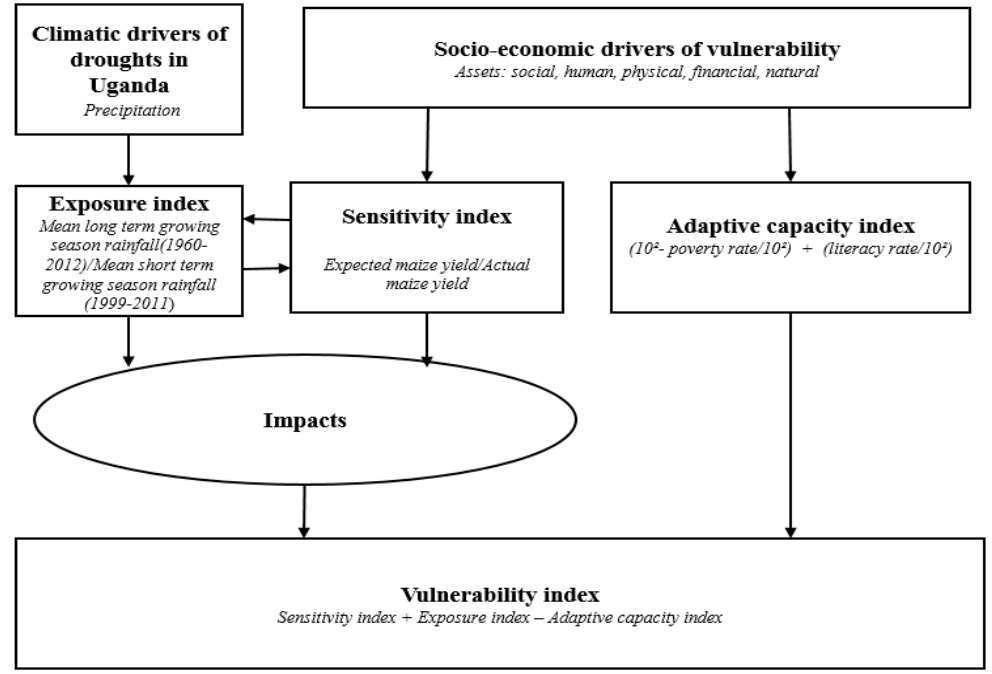
Figure 1. Theoretical framework for assessing vulnerability and the summary of the quantification procedure.